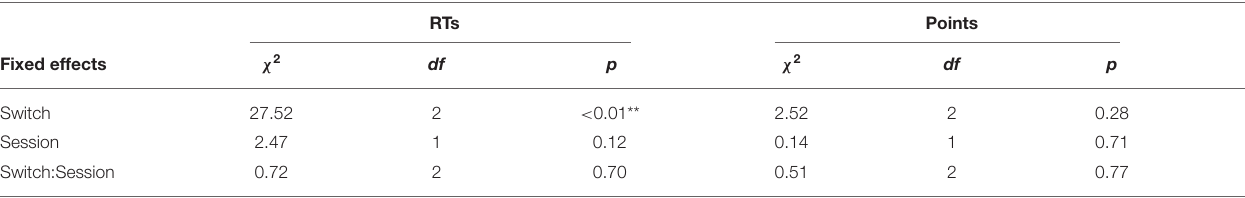
TABLE 3 | Summaries of the Wald χ 2 tests in the LMEs for RTs and points. RTs